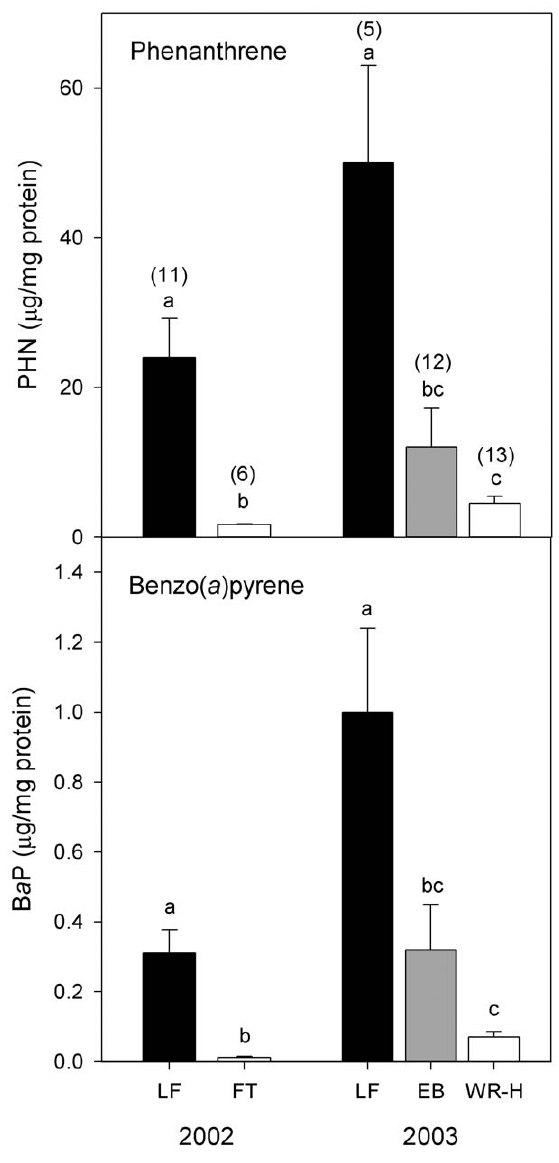
Figure 5. Analysis of bile from affected coho spawners indicates exposure to polycyclic aromatic hydrocarbons (PAHs). Concentrations of fluorescent PAH metabolites (as phenan- threne [PHN] and benzo- a -pyrene [BaP] equivalents) in the bile of coho collected in an urban stream (Longfellow Creek; LF) are shown relative to fish from a non-urban stream (Fortson Creek; FT) and a non-urban hatchery (Wallace River Hatchery; WR-H). In 2003, seawater-phase coho (pre-freshwater entry) were also sampled from urban Elliott Bay (EB). The bile data demonstrate a significant increase in PAH exposure after coho spawners transition from a highly urbanized estuary to freshwater spawning habitats. Sample sizes, the same for PHN and BaP, are indicated over each bar. Error bars are 1 standard error of the